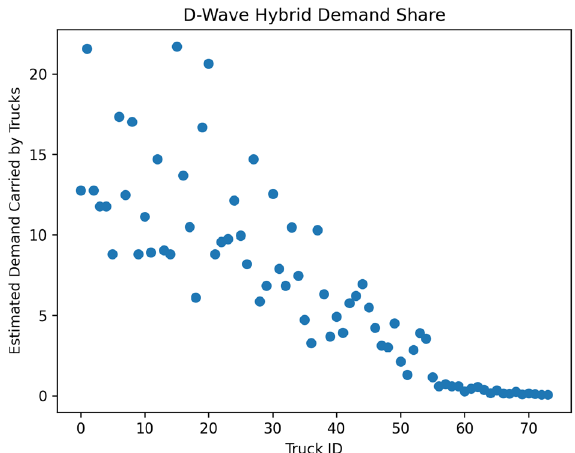
Figure 5. Estimated demands computed during the truck loop process using the D-Wave Hybrid solver. The algorithm terminated after 74 trucks were given routes. Note that the last 15 trucks consume a very small amount of demand, suggesting that they can be replaced by a smaller number of trucks. Demands are estimated by the method explained in “Supply chain